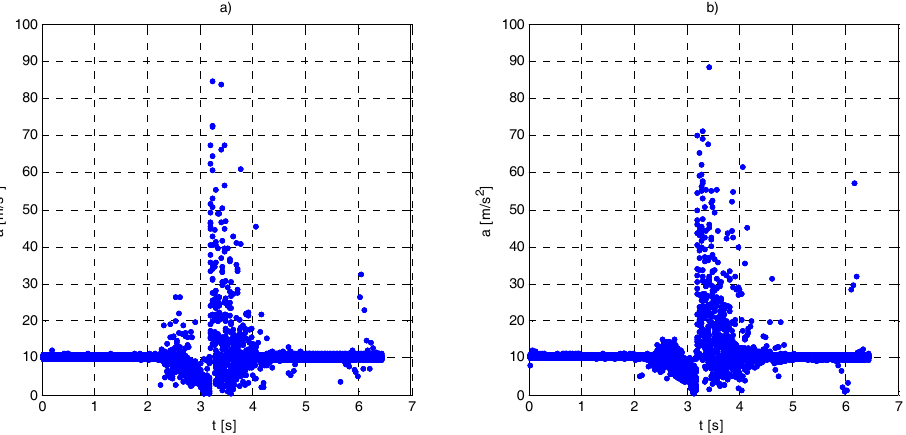
Figure 19. Acceleration magnitude versus time during 20 falls: ( a ) tag attached to the manikin waist; and ( b ) tag attached to the wrist.